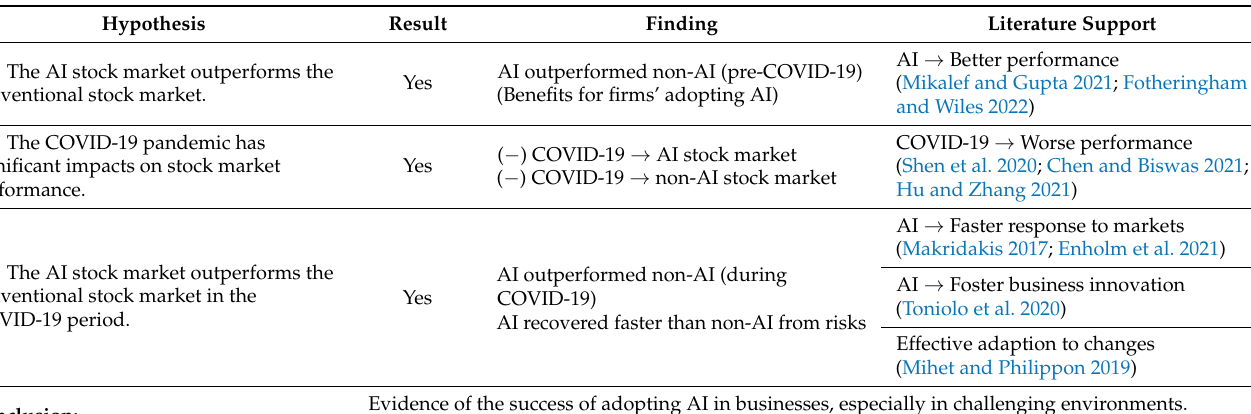
Table 6. Finding